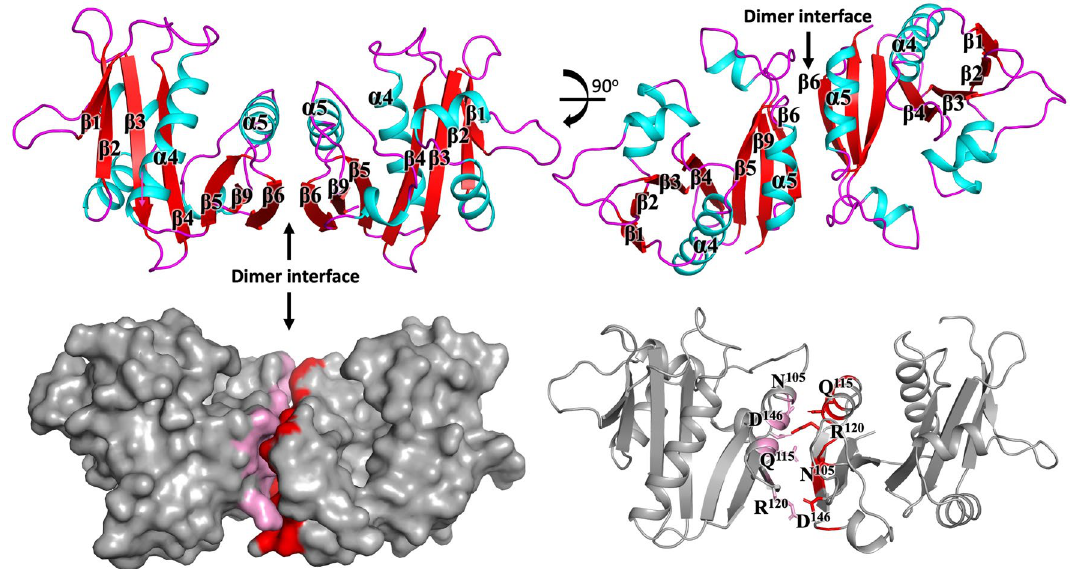
Figure 4. The structure of the GNAT acetyltransferase from Elizabethkingia anophelis exhibits a significant dimer interface . The secondary structural elements mediating the dimer interface are presented in the left panels. Residues within α-helix five are depicted in the right panel and pack form an array of hydrogen bond and salt bridge interactions summarized in Tables 3 and 4.